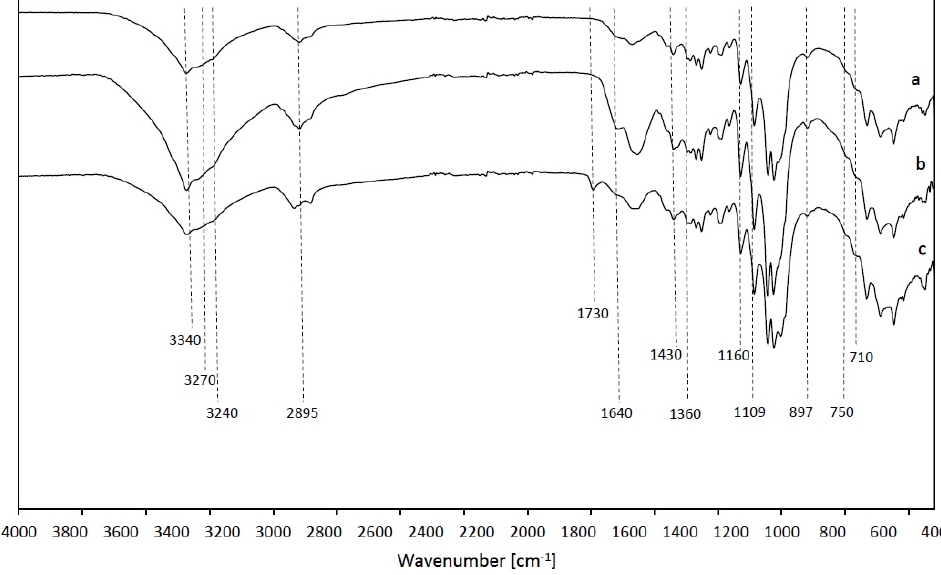
Figure 7. FTIR spectra of bacterial cellulose samples. ( a ) HS; ( b ) HS-C + WGB; ( c ) WGB.